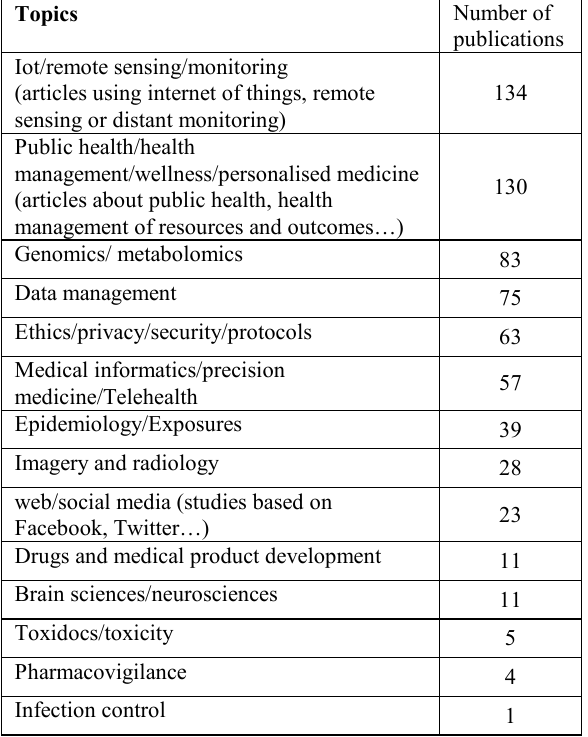
Figure 2. Distribution of publications per Family of